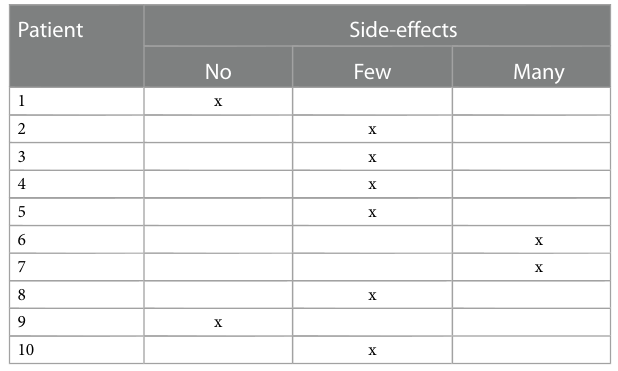
TABLE 3 Parents ’ experience of their child ’ s side-effects during maintenance